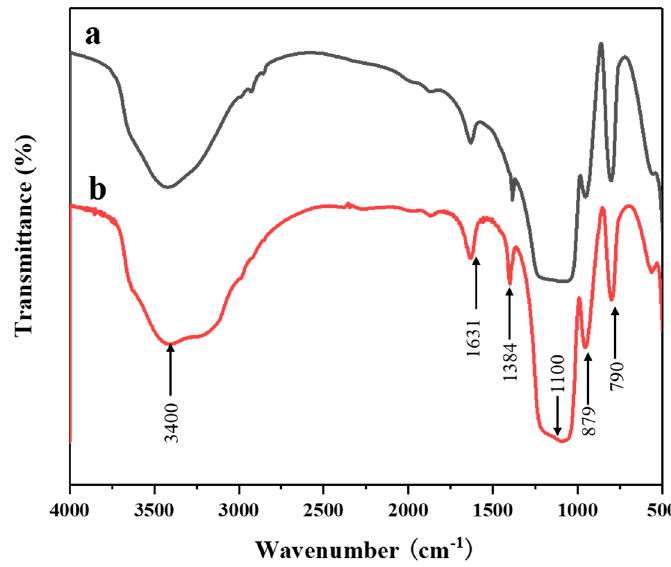
Figure 3. Fourier transform infrared spectra (FTIR) spectra of sample ( a ) SiAl-1 and ( b ) SiAl-2.